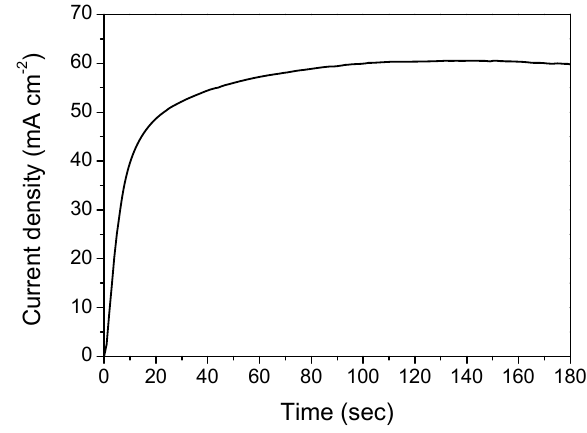
Figure 2. Dissolution current of Ti substrate in DMSO 2 - Fig. 2: AlCl 3 bath at 2 V vs. Fig. 2: